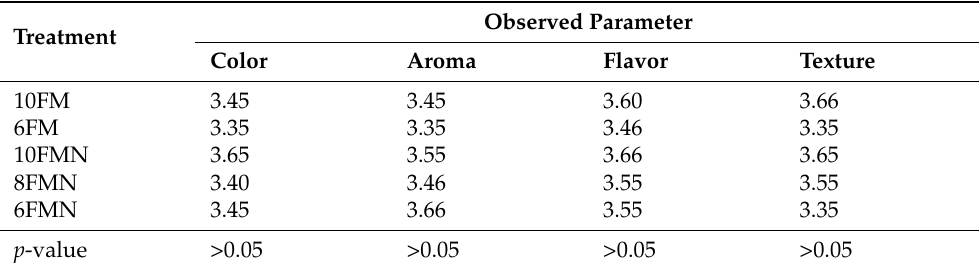
Table 5. Results of organoleptic assessment of Pacific white shrimp (PWS) fed with different diets for 110 days (n = 15 per group).